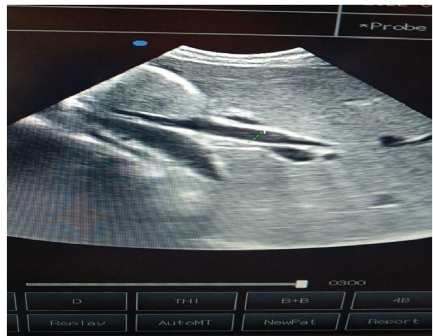
Figure 3: Ultrasound image showing normal common bile duct after worm